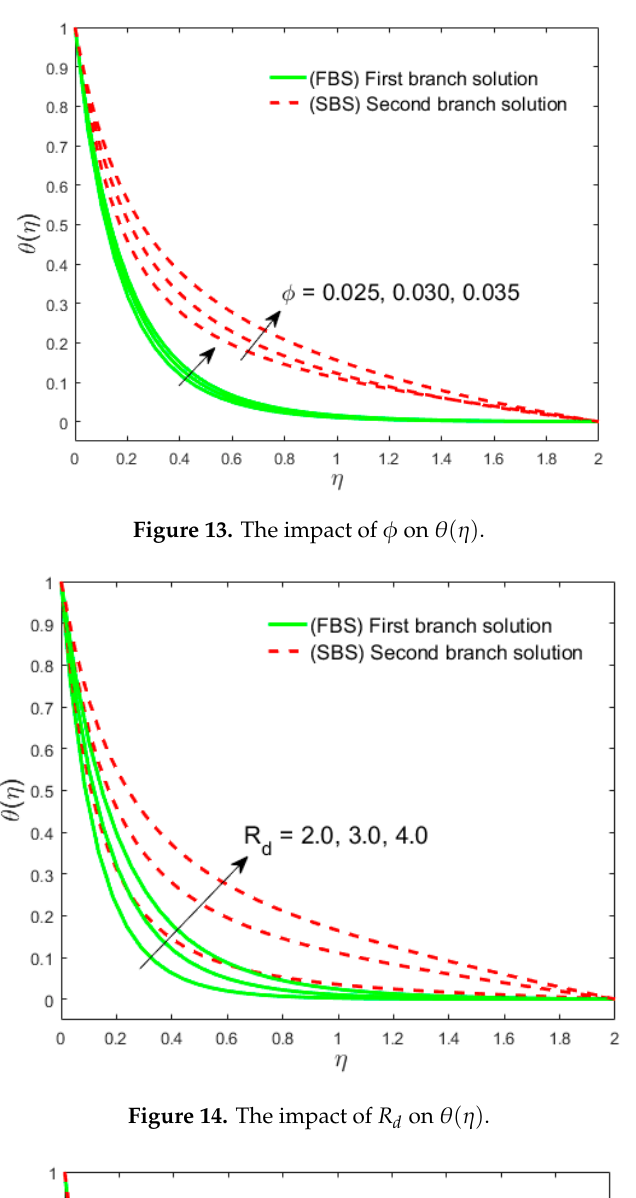
Figure 14. The impact of d R on